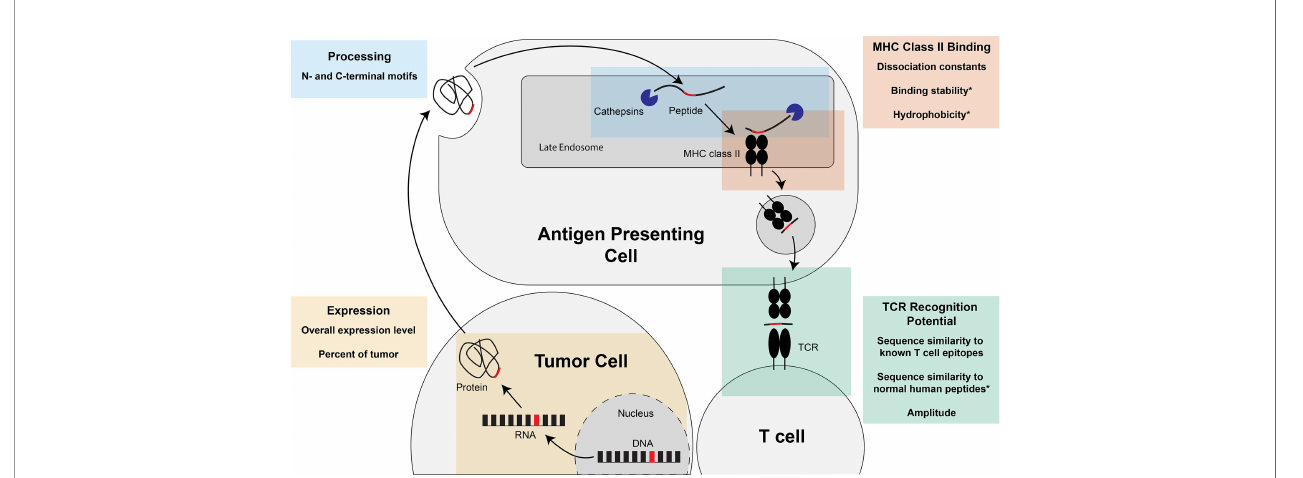
FIGURE 5 | Steps of MHC class II-restricted neoantigen prioritization and summary of characteristics considered for each step. Mutations in the DNA of a tumor cell are transcribed into RNA and translated into a protein. The protein can either be taken up into the endocytic compartment of an antigen presenting cell or processed and presented by the tumor cell if the tumor cell expresses MHC class II (not pictured). In the late endosomes, protein cleavage and MHC class II loading occurs. The protein is cleaved by cathepsins at the N- and C-termini before and after binding to the MHC class II molecule. If the peptide is successfully bound to MHC class II, the peptide:MHC complex is transported to the cell surface where the peptide: MHC complex has the opportunity to be recognized by the T cell receptor (TCR). Characteristics of the neoantigen encompassing expression, processing, MHC class II binding, and TCR recognition potential that may enhance prioritization of MHC class II-restricted neoantigens are summarized in each of the boxes in the fi gure. * indicates characteristics that, to our knowledge, have not been assessed for the prioritization of MHC class II-restricted